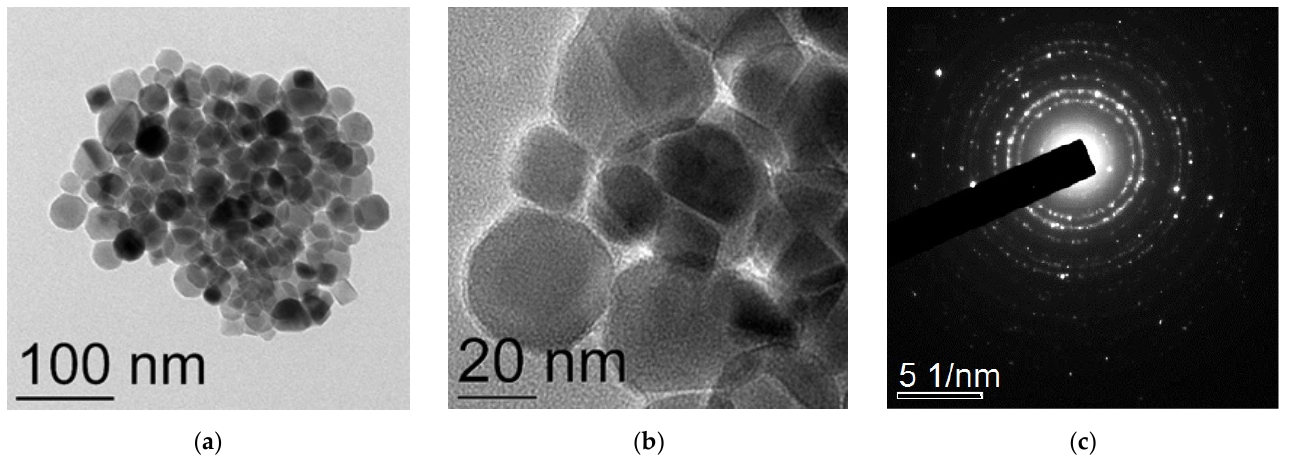
Figure 3. TEM images ( a , b ) with different magnification and SAED pattern ( c ) of the Fe 3 O 4 @C one step synthesized NPs.